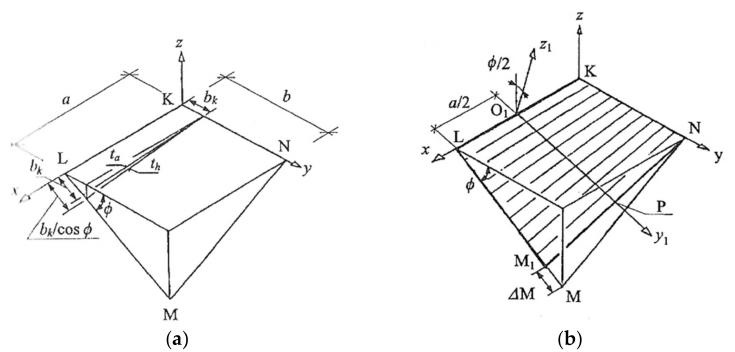
Figure 5. Adjustment of the longitudinal fold’s axes to a few selected rulings of one-fourth of a right hyperbolic paraboloid, forcing significant change in the width of the transverse fold’s ends: ( a ) forced change of transverse edge of individual transformed sheet, ( b ) forced change of transverse edge of complete transformed